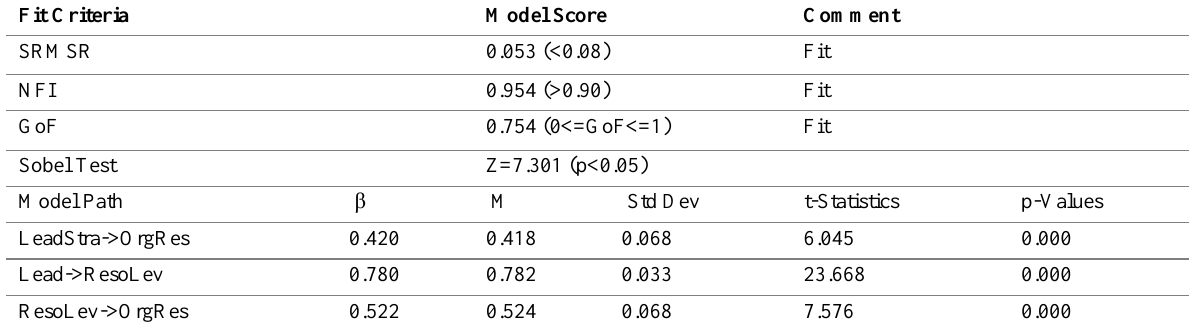
Table 6: Model Fit Criteria for Resource